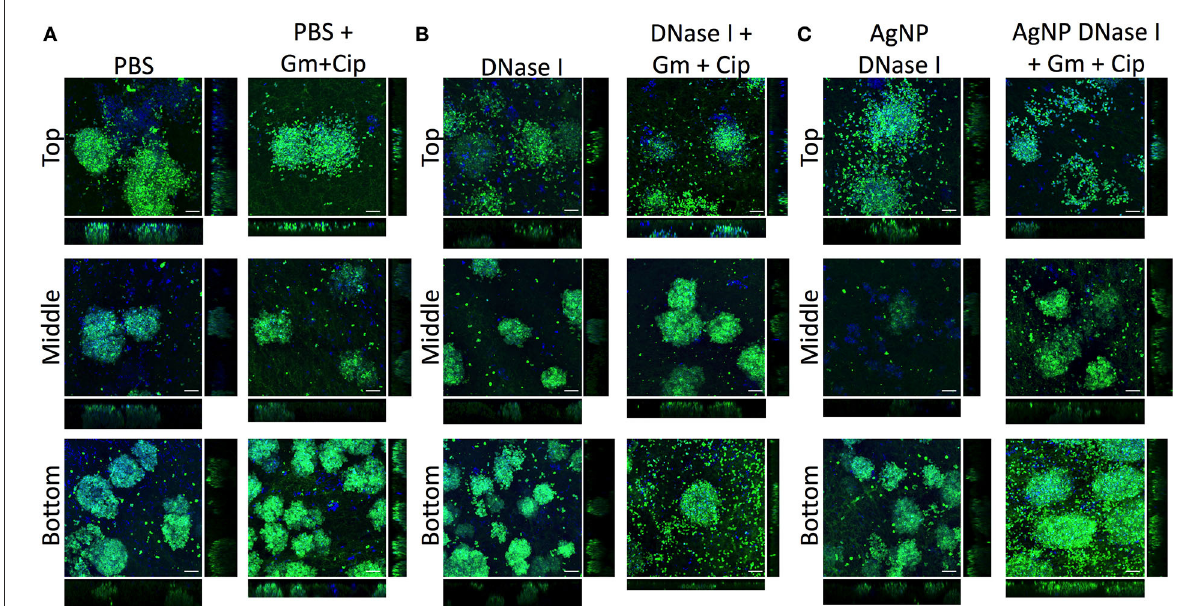
FIGURE6 Distribution and colocalization of P. aeruginosa PAO1 and S. aureus SA31 in the WLB after using DNase I treatment. Analysis of the top, middle, and bottom parts of a wound-like biofilm treated with DNase I alone or combined with gentamicin and ciprofloxacin. (A) Gentamicin (Gm) and ciprofloxacin (Cip) treatment, (B) gentamicin and ciprofloxacin treatment in combination with soluble DNase I, and (C) gentamicin and ciprofloxacin treatment in combination with encapsulated DNase I on silver nanoparticles (AgNP). The Bacterial Viability and Gram Stain Kit differentiated P. aeruginosa (blue) and S. aureus (green). The scale bars at the bottom-right corner of the images represent 10 µ